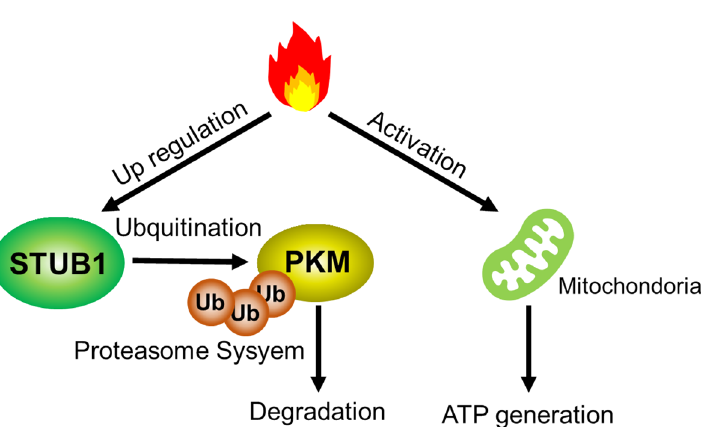
Figure 6. A proposed mechanism of ATP metabolic adaptation in response to hyperthermia in resistant SKOV3 cells. Hyperthermia upregulates the STUB1 E3 ligase in hyperthermia resistant ovarian SKOV3 cells. STUB1 causes degradation of a glycolysis enzyme, PKM1/2, through the ubiquitin proteasome system, causing inhibition of glycolytic activity. On the other hand, mitochondrial activity is upregulated in response to hyperthermia, which promotes ATP